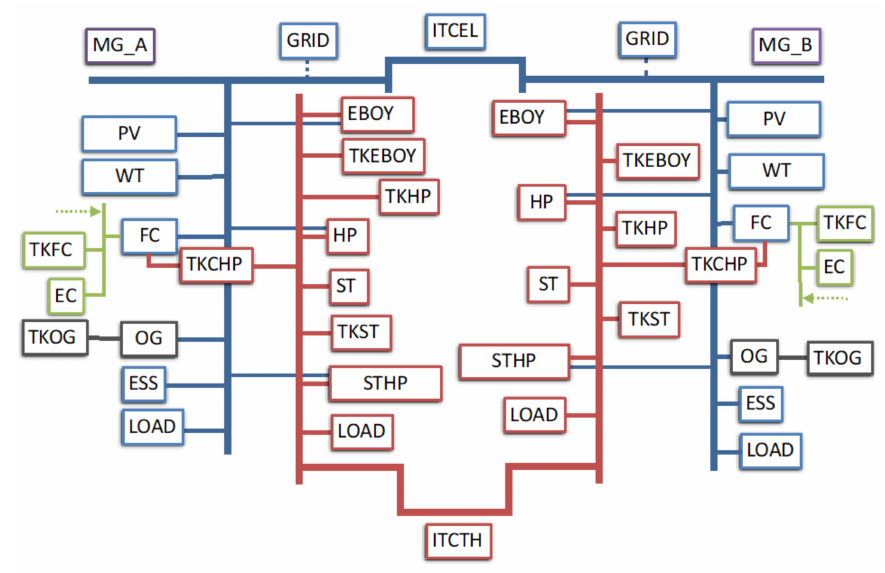
Figure 3. The overall architecture of two CHP-MMG comprising 36 DER, 2 electrical, thermal